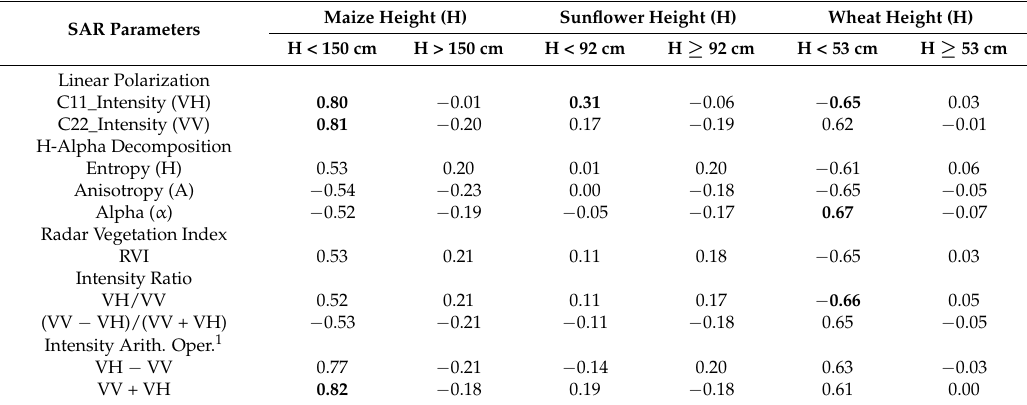
Table 3. Coefficient of determination (R 2 ) between crop height and Sentinel-1 SAR parameters.